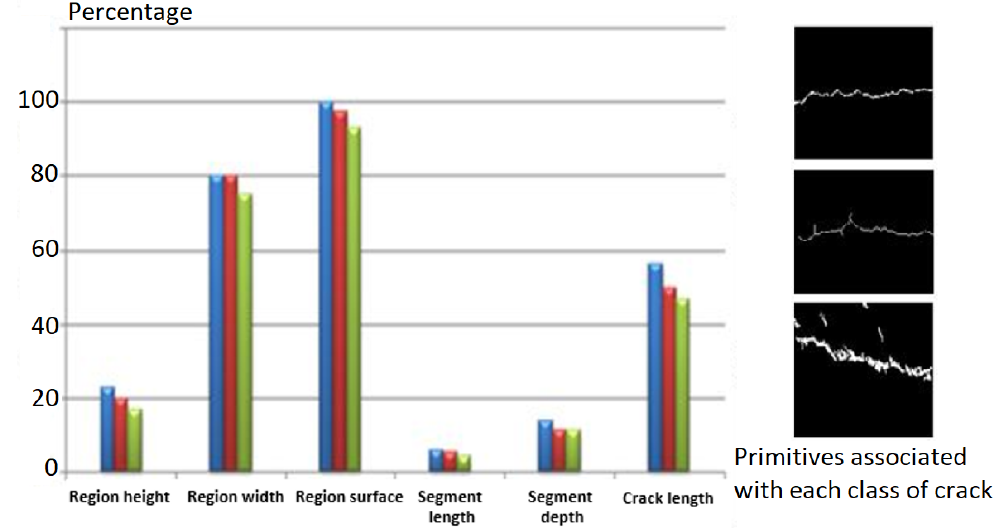
Figure 14. Variation of primitives for a transversal crack. The red, blue, and green colours represent three samples from the same transversal class to prove the intraclass variations of the